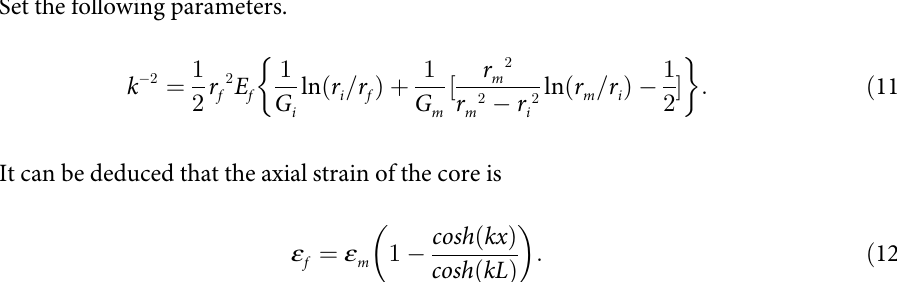
It can be deduced that the axial strain of the core is